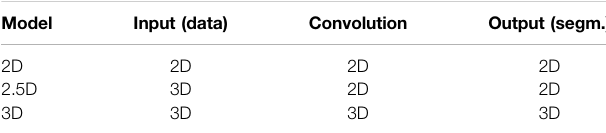
TABLE 2 | Modular U-Net variations: input, convolutional layer, and output nature (2D or 3D).